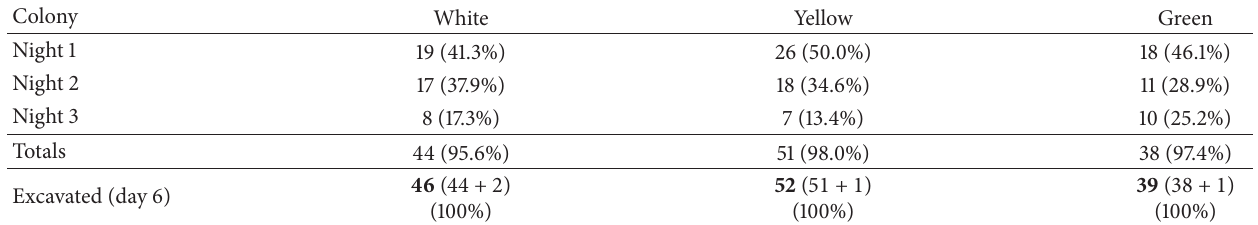
Table 1: The numbers of previously unmarked foraging workers departing 3 Nothomyrmecia macrops nests on 3 consecutive experimental nights, with the total numbers present in each nest as determined by a later excavation. Percentages are those of the full tallies for day 6. Colony White